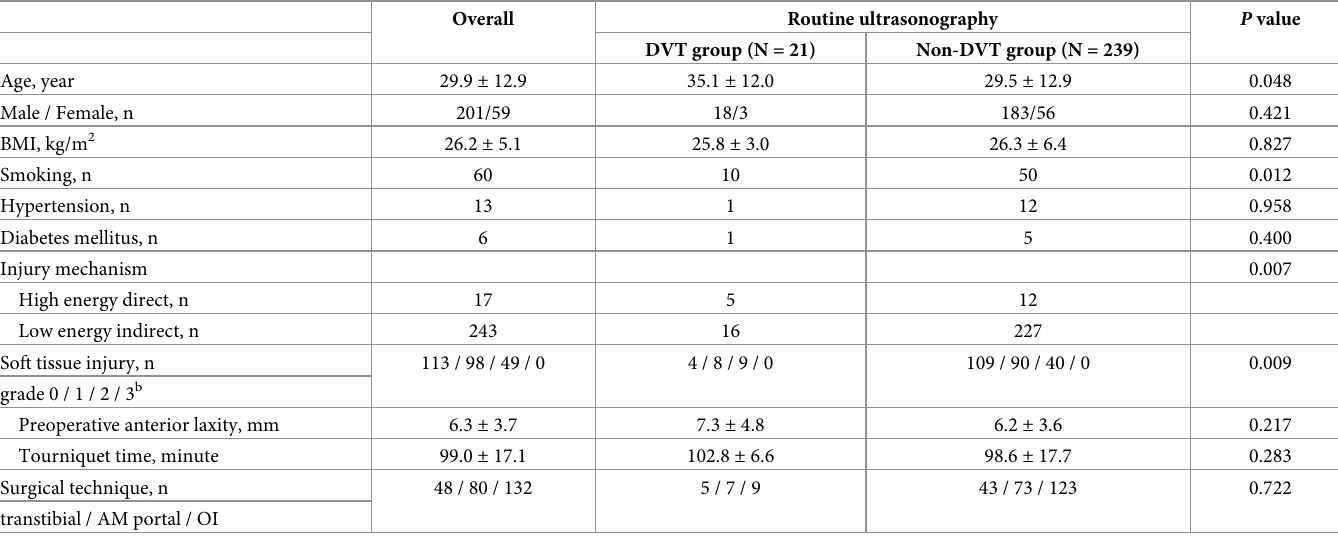
Table 1. Patient characteristics between the DVT and the non-DVT